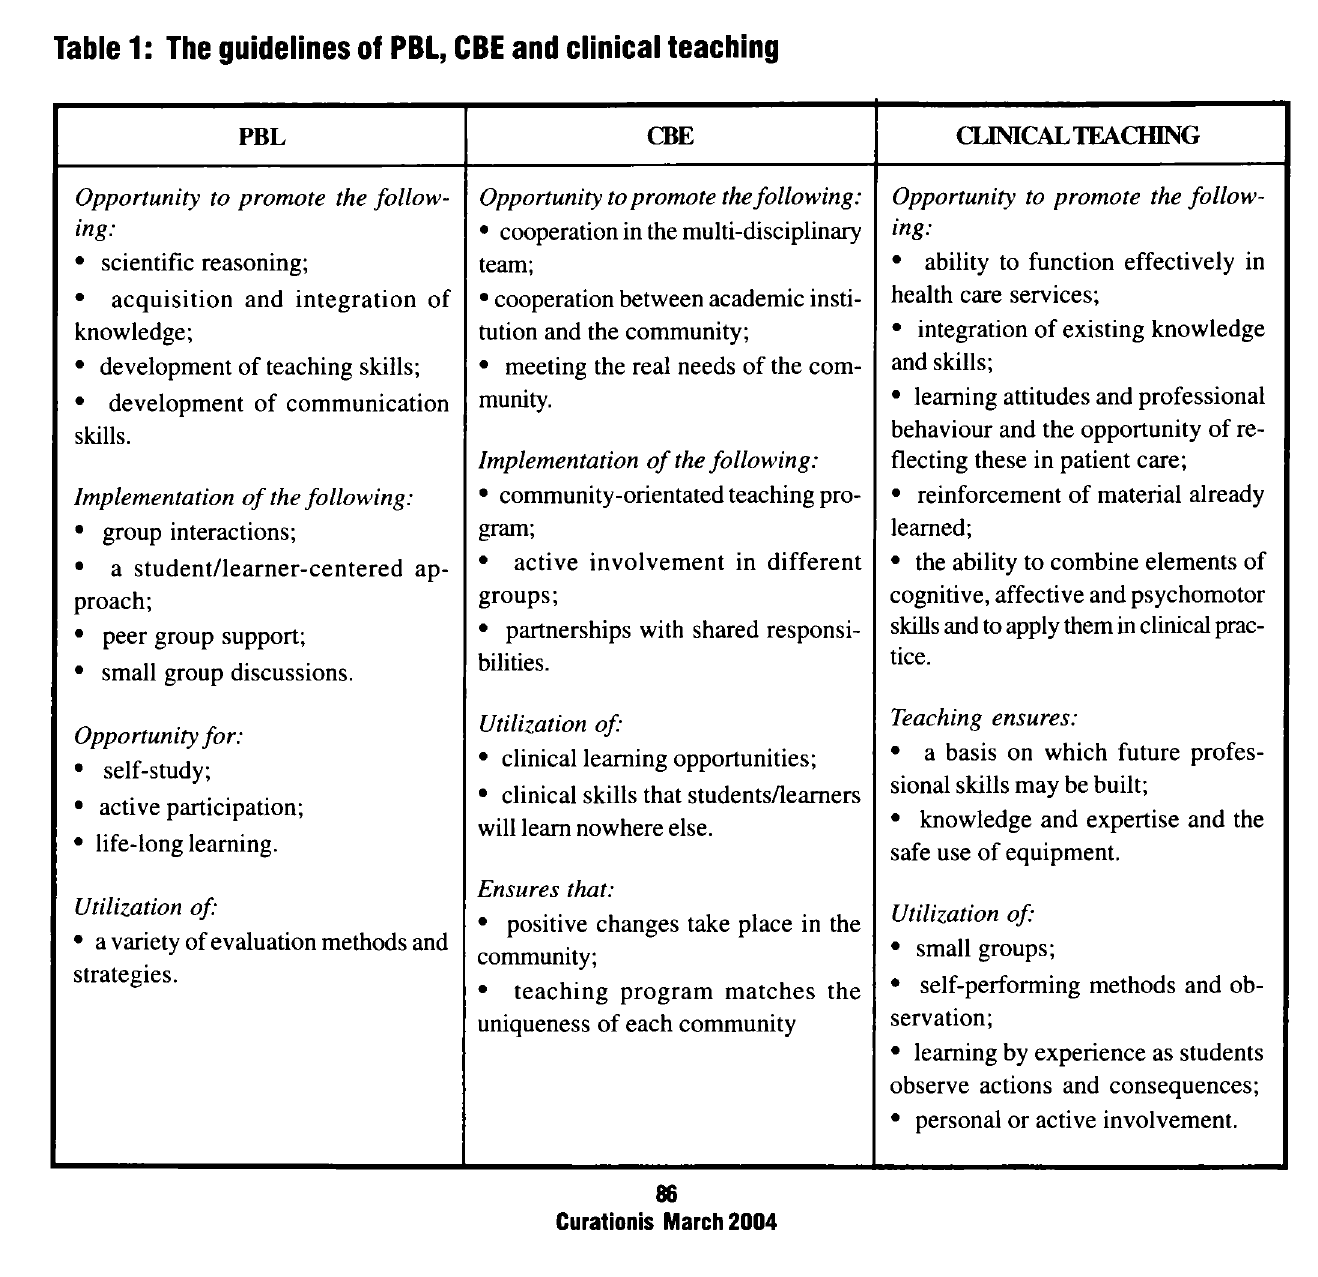
Table 1: The guidelines of PBL, CBE and clinical teaching